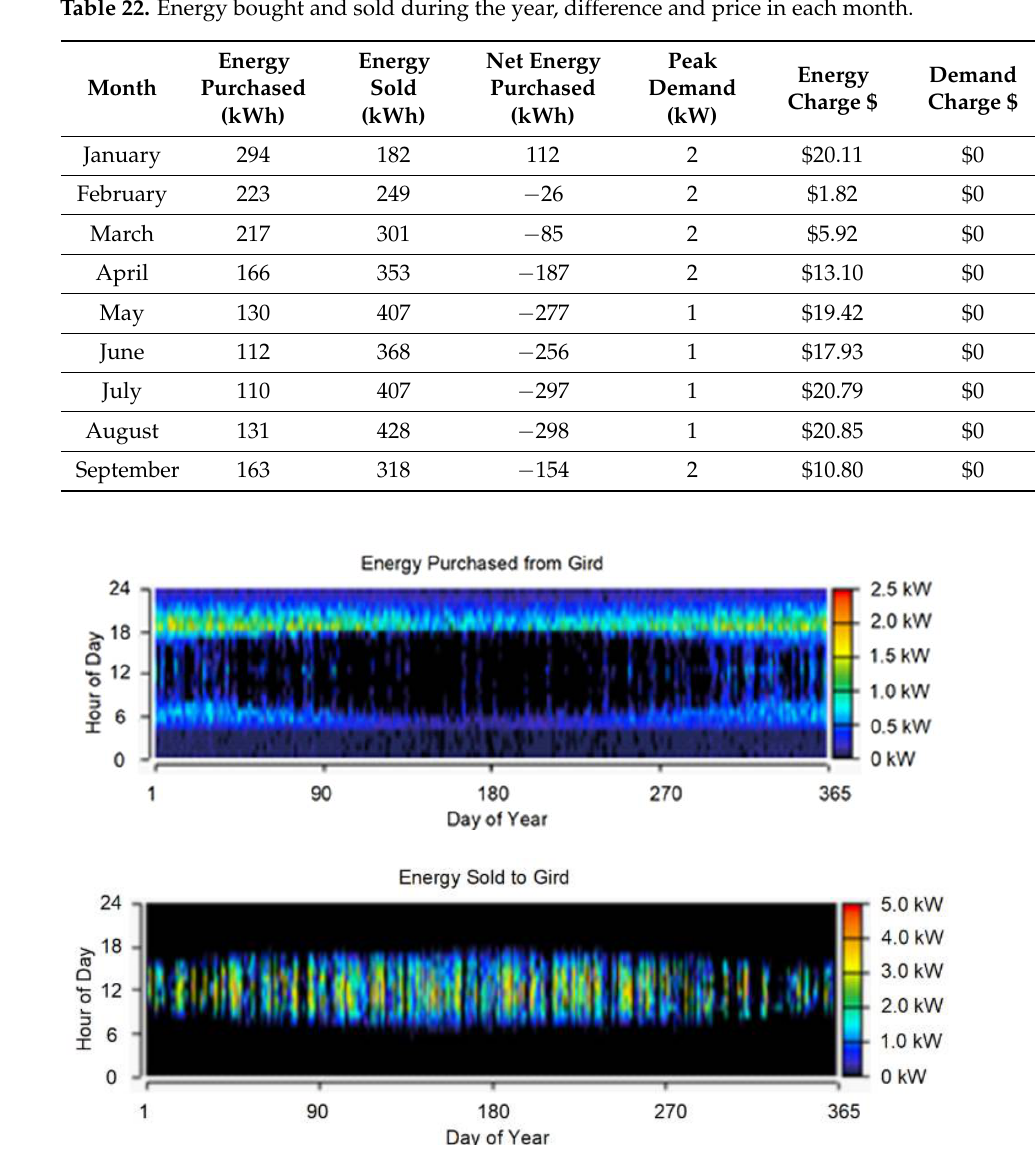
Table 22. Energy bought and sold during the year, difference and price in each month.